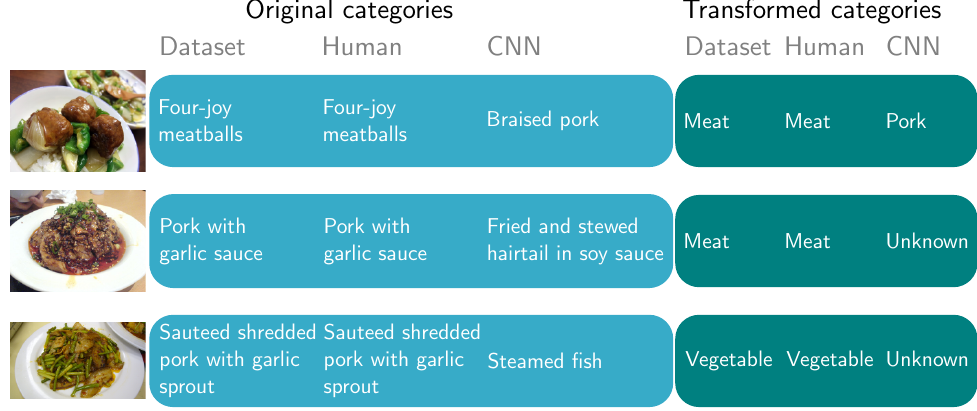
Figure 15. Classification of selected images from VireoFood-172 dataset [58] by ASIA population. When using original categories CNN classification are different from true category. Images are only examples to visually represent a dataset category. They are not part of the dataset. <four-joy meatballs> photo by Yoppy licensed under CC BY 2.0, <pork with garlic sauce> photo by Irrational Cat and <sauteed shredded pork with garlic sprout> photo by Kent Wang licensed under CC BY-SA 2.0.